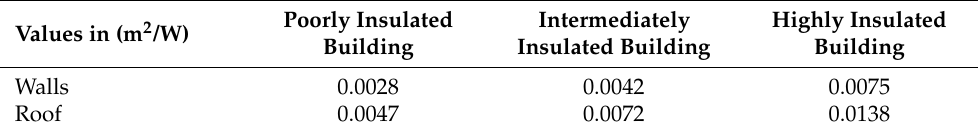
Table 2. Values for the constant k of Equation